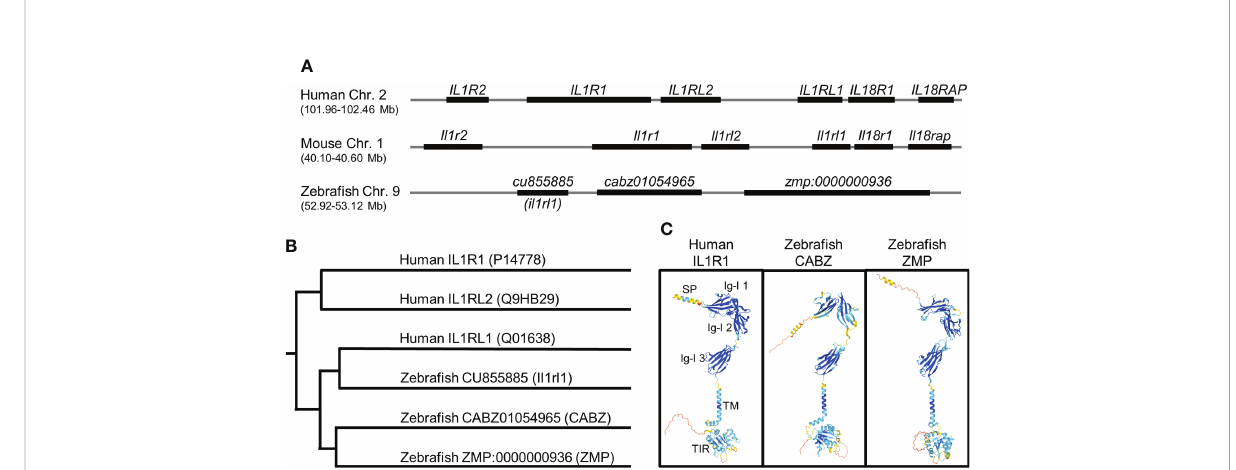
FIGURE 1 In silico identi fi cation of the putative zebra fi sh interleukin-1 receptor, type 1 (Il1r1). (A) Alignment of human, mouse, and zebra fi sh genomic regions showing conserved synteny. Shown here are the human and mouse IL-1 receptor clusters and the putative zebra fi sh IL-1 receptor cluster (not to scale). (B) Phylogenetic alignment of human IL1R protein sequences with putative zebra fi sh Il1r protein sequences. (C) Predicted protein structures of human IL1R1, zebra fi sh CABZ (CABZ01054965), and zebra fi sh ZMP (ZMP:0000000936) showing conserved domains: N- terminal signal peptide (SP), 3 extracellular immunoglobulin-like (Ig-l) domains (Ig-l 1, Ig-l 2, and Ig-l 3), a single transmembrane domain (TM), and an intracellular Toll/Interleukin-1 receptor